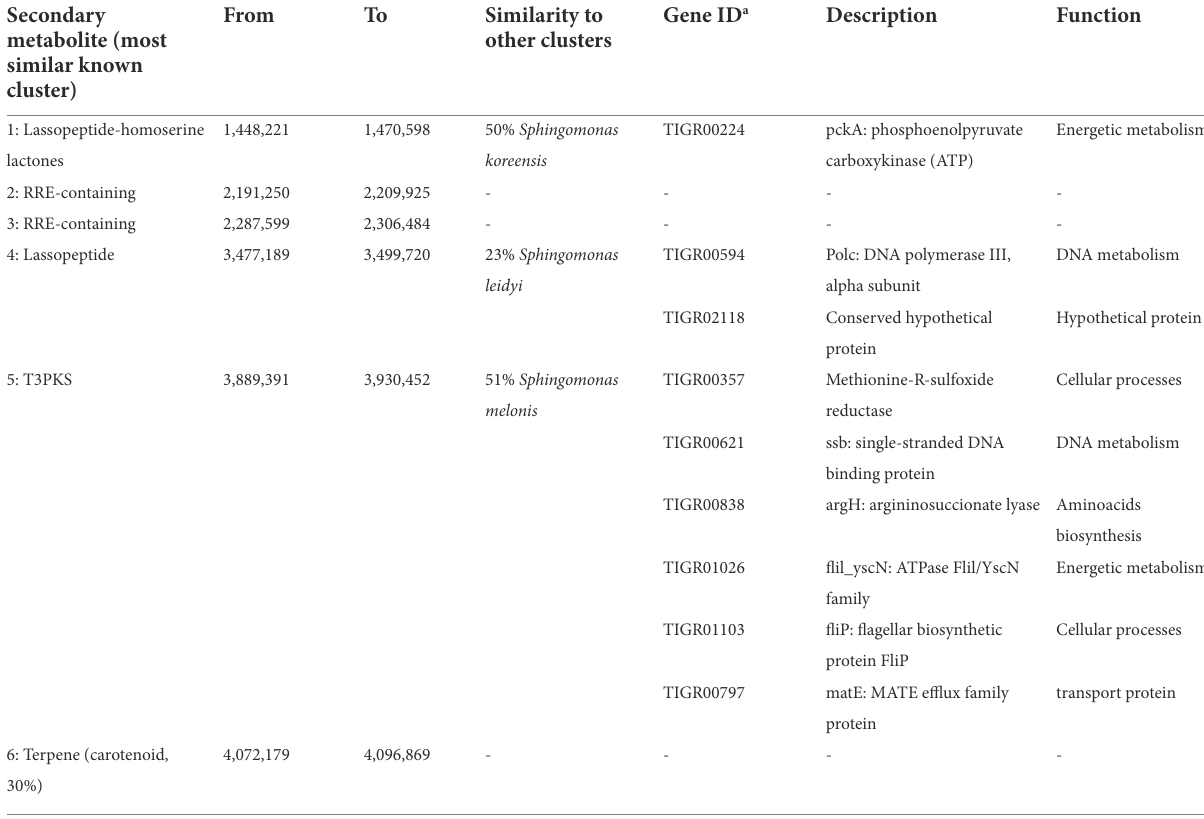
TABLE 1 Summary of Biosynthetic Gene Cluster (BGC) identified in the genome of Antarctic Sphingomonas sp. So64.6b and their genes related with auto-resistance to antibiotics when present on ARTS prediction. Secondary metabolite (most similar known cluster)